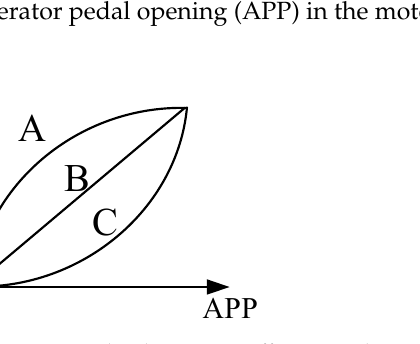
Figure 2. Motor load torque coefficient and accelerator pedal opening function.